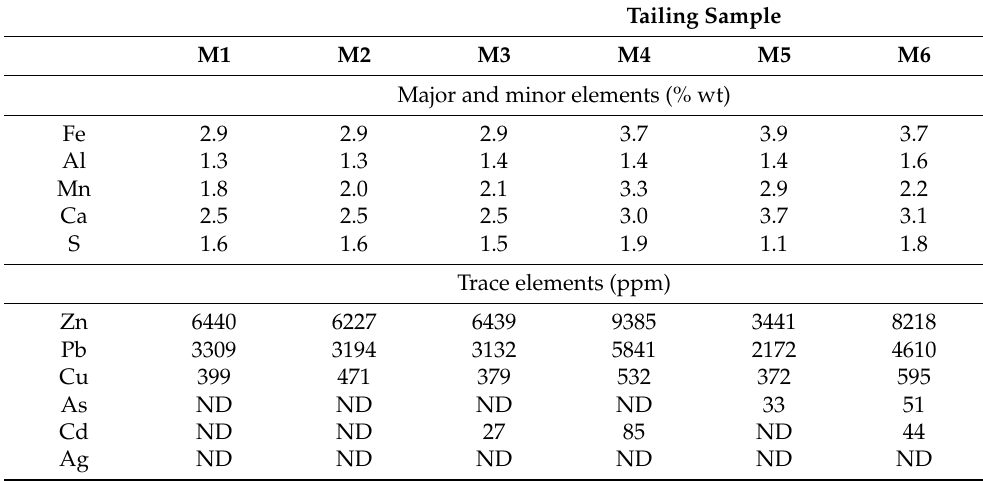
Table 2. Chemical composition of tailings